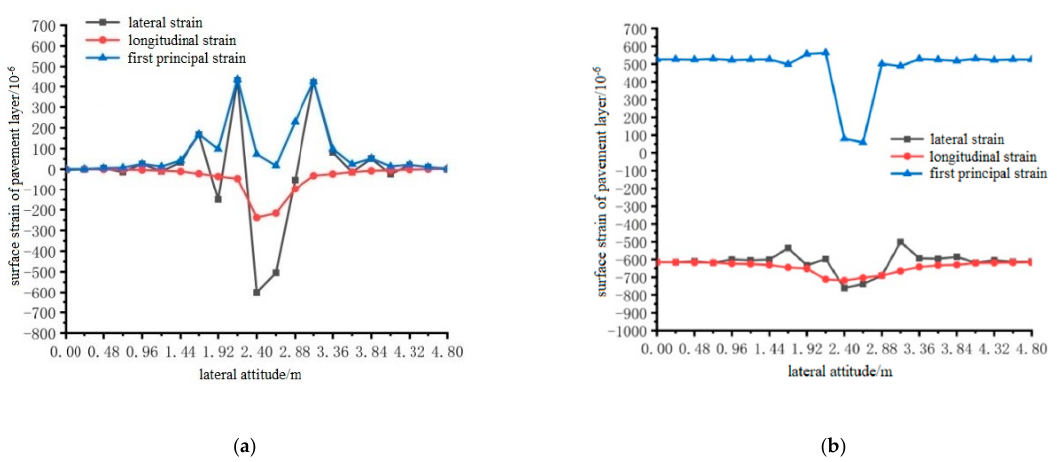
Figure 28. The transverse distribution of longitudinal and transverse strain on the surface of the pavement layer with and without temperature field under the action of load level 2. ( a ) Longitudinal and transverse strain diagrams without temperature field effect. ( b ) Longitudinal and transverse strain diagrams with temperature field effect.